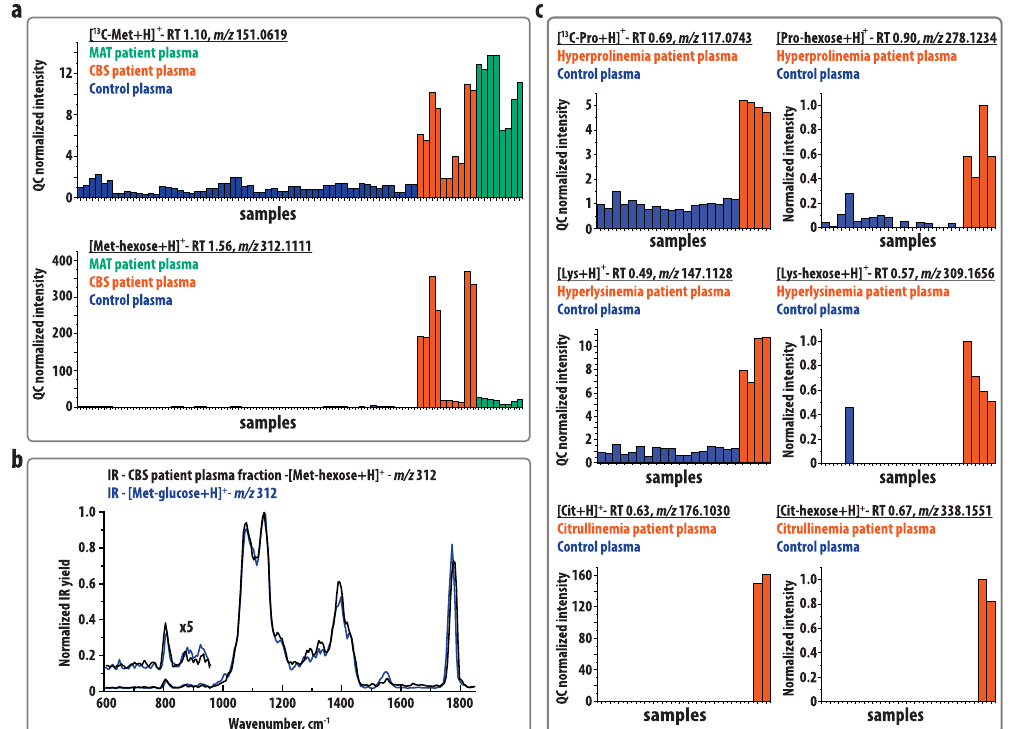
Fig. 3 Results showing ARP formation from other accumulating amino acids. a Intensity plots of protonated methionine (Met) ( m/z 150.0589), and the Met-hexose conjugate ( m/z 312.1110) observed in plasma samples of methionine adenosyltransferase I/III de fi ciency (MAT) patients (green), cystathionine beta-synthase de fi ciency (CBS) patients (red), and control plasmas (blue). The average fold changes (patient/control) of Met and the Met- hexose are determined at 11 and 16 for MAT and 6 and 164 for CBS, respectively. b IRIS spectra of the protonated ion ([M + H] + , m/z 312) of the Met- hexose isolated from CBS patient plasma and the Met-glucose reference standards. c Intensity plots of protonated 13 C-proline and lysine and their hexose conjugate observed in two plasma samples of patients (red) and 14 controls (blue), and of protonated citrulline and the citrulline-hexose conjugate observed in one plasma sample of a citrullinemia patient (red) and 17 controls (not visible on this scale). The ordering of samples is the same between the left and right panels. Most samples were analyzed as two technical replicates, shown as consecutive bars in the fi gures. A more-extended fi gure caption is available in Fig.